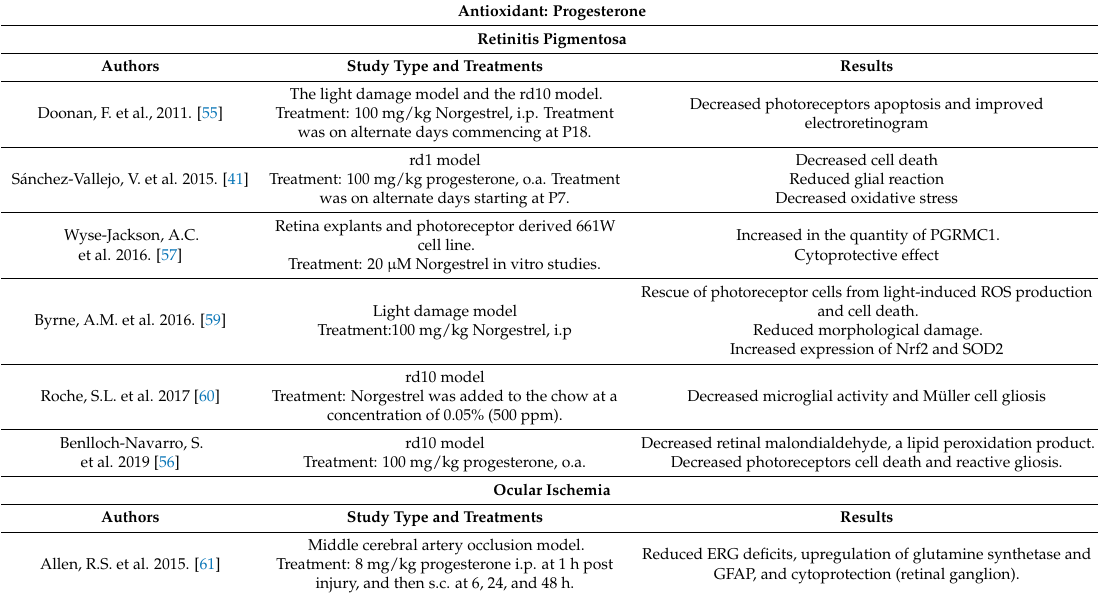
Table 1. Antioxidant effects of progesterone in experimental models of retinal pathology.